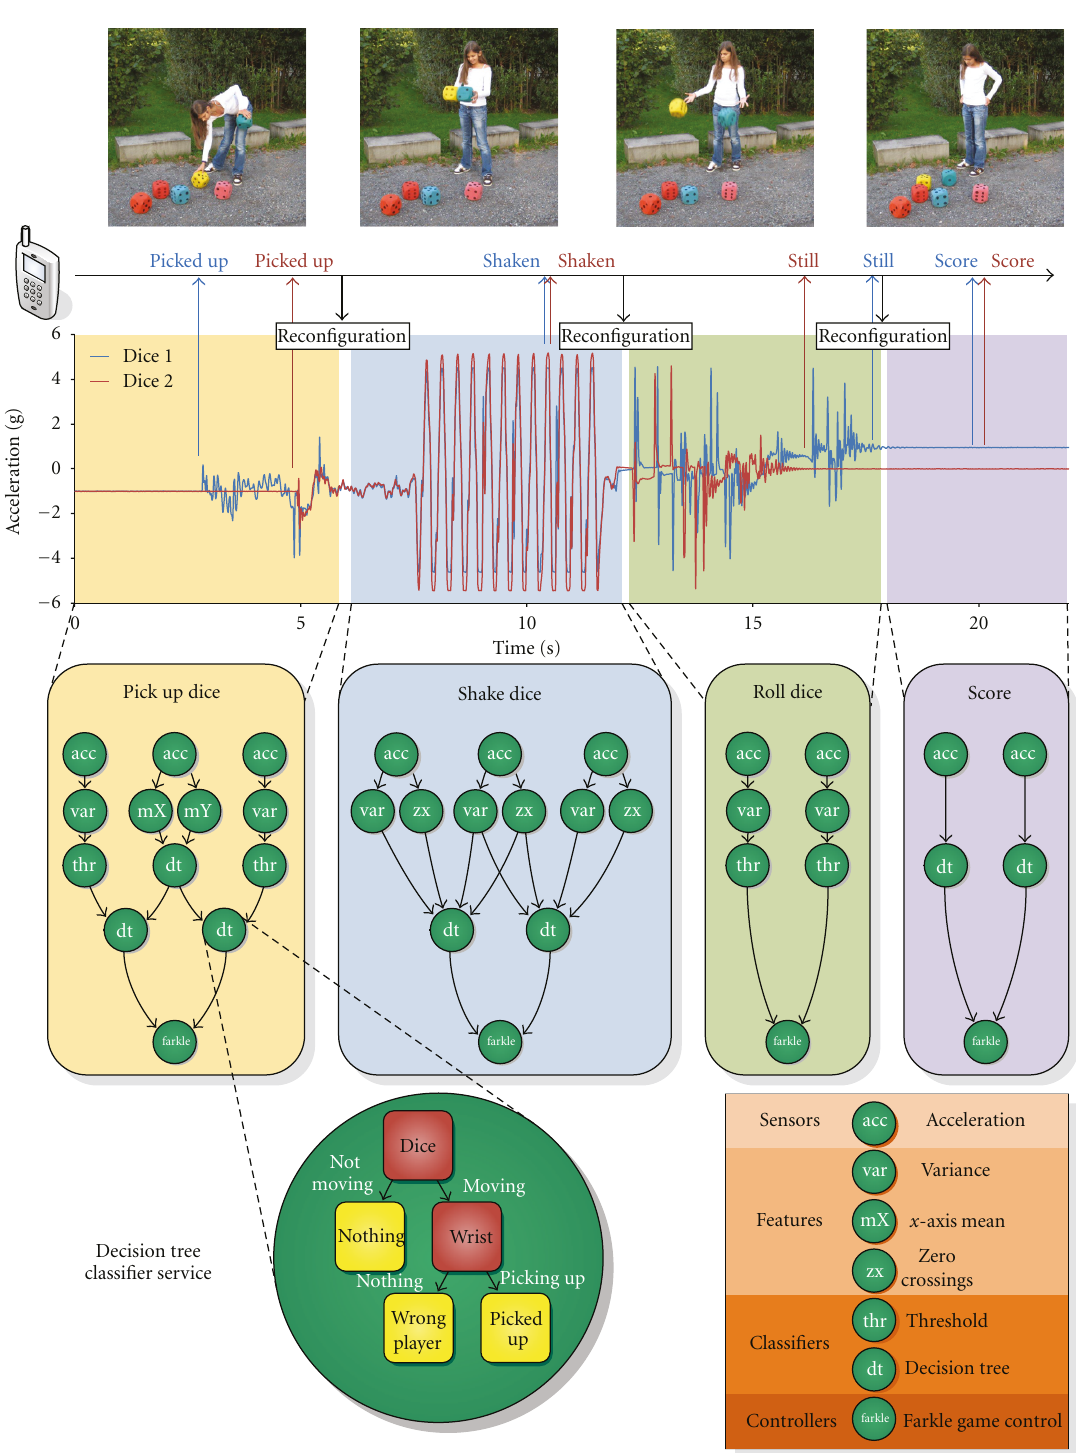
Figure 6: Illustration of the four Farkle game states, including the user action (top), the acceleration signals recorded on two dice for one throw (middle), and the individual service graphs for each game state (bottom). Every service is customized for the Farkle game state, as shown on the example of a decision tree